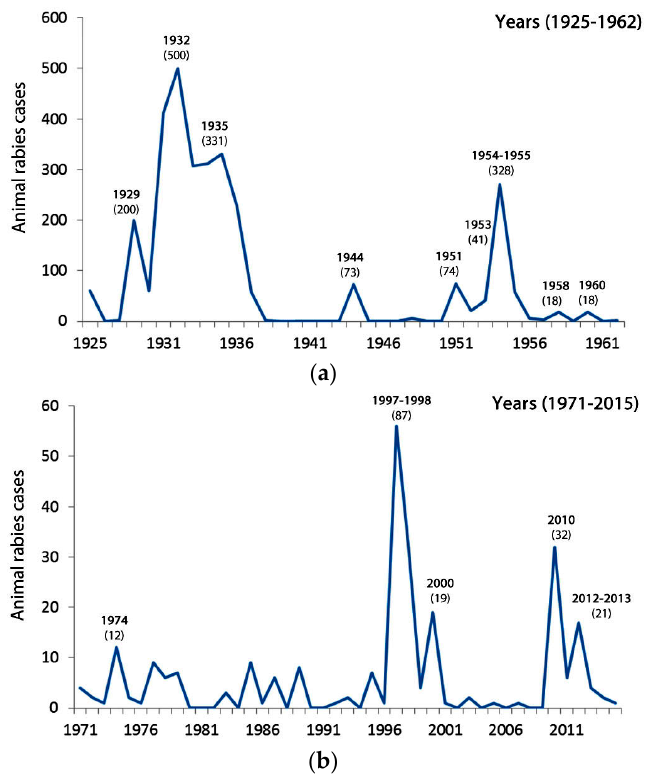
Figure 2. Animal rabies cases reported in Trinidad during the periods ( a ) 1925–1962 and ( b ) 1971–2015.